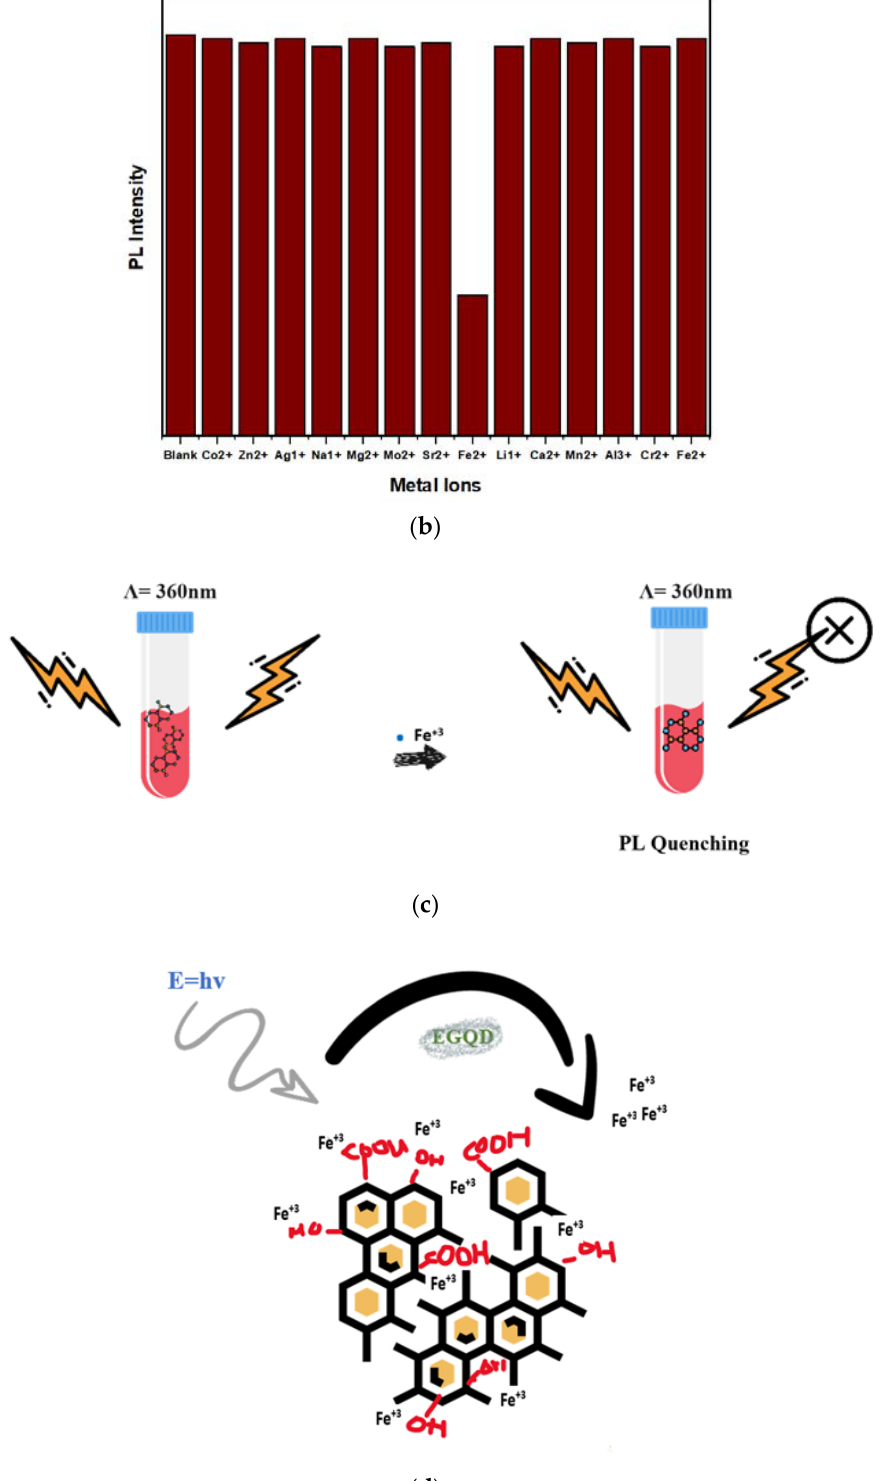
Figure 5. ( a ) PL spectra of GQD/300 in the presence of various concentrations of Fe 3+ ions ( b ) comparison of the photoluminescence intensities of 55 g mL − 1 GQD/300 solution containing various metal ions at an excitation wavelength of 360 nm. ( c ) Shows the schematic of fluorescence quenching. ( d ) Fluorescent quenching mechanism of the GQD/300 in presence of the Fe 3+ metal ions.